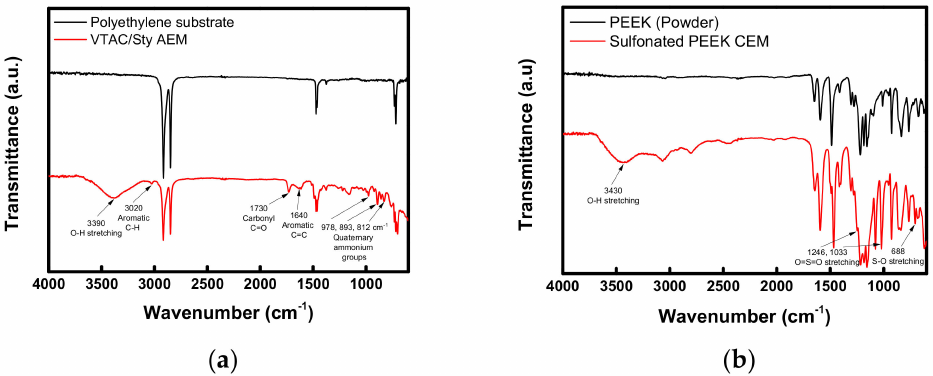
Figure 4. FT-IR spectra of ( a ) PE porous substrate and pore-filled AEM, and ( b ) PEEK and SPEEK